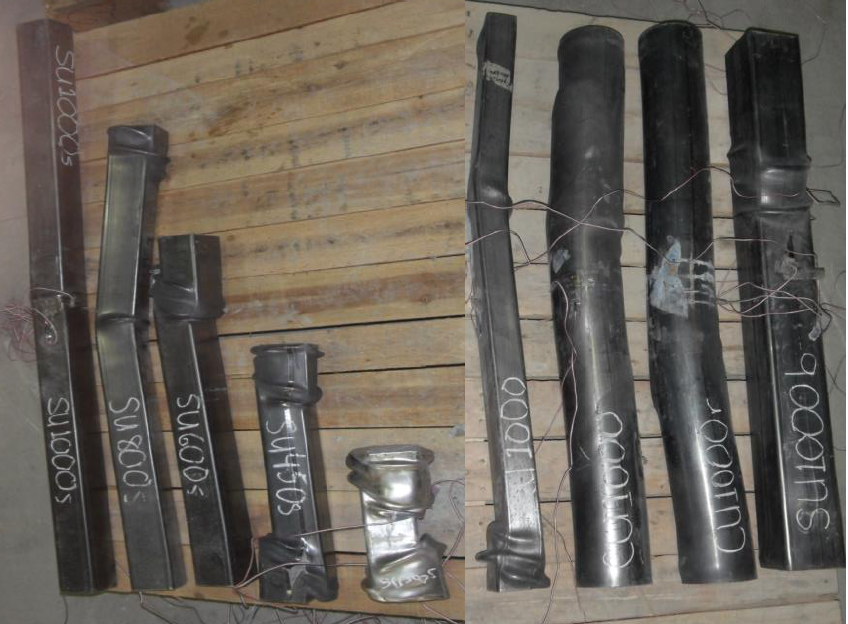
Figure 5. Failure modes of UHSC-filled CFST columns (from left: Us2-20, Us2-16, Us2-12, Us2-9, Us2-6, Ur-20, UcI-9, UcII-9, and Us4-10).